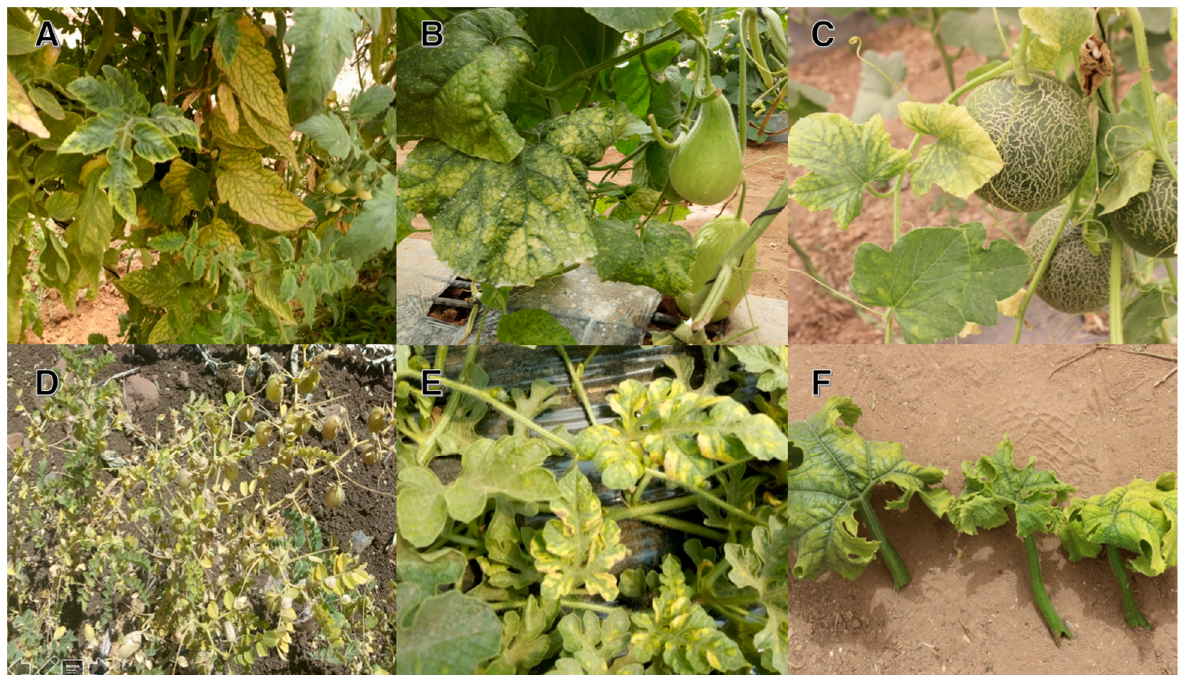
Figure 2. Symptoms of virus infections on solanaceous and cucurbitaceous crops. ( A ) Tomato plant with the ToLCNDV infection, ( B , C ) melon plants with the ToLCNDV infection, and ( D ) chickpea plant with the CpCDV infection. ( E ) Symptoms of yellowing and curling on watermelon and ( F ) zucchini leaves collected from a ToLCNDV-infected plant.